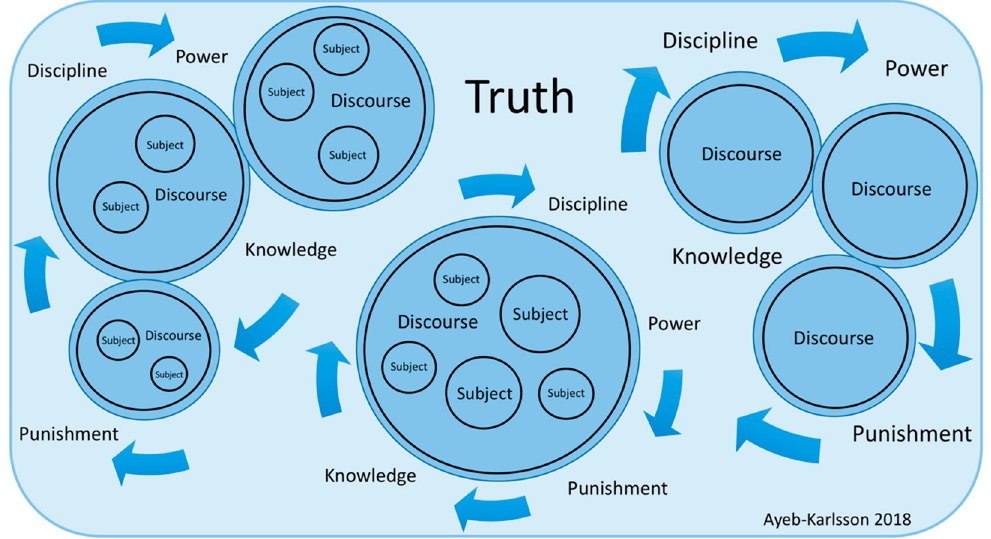
Figure 1. A subject positioned within power and knowledge discourse relations.